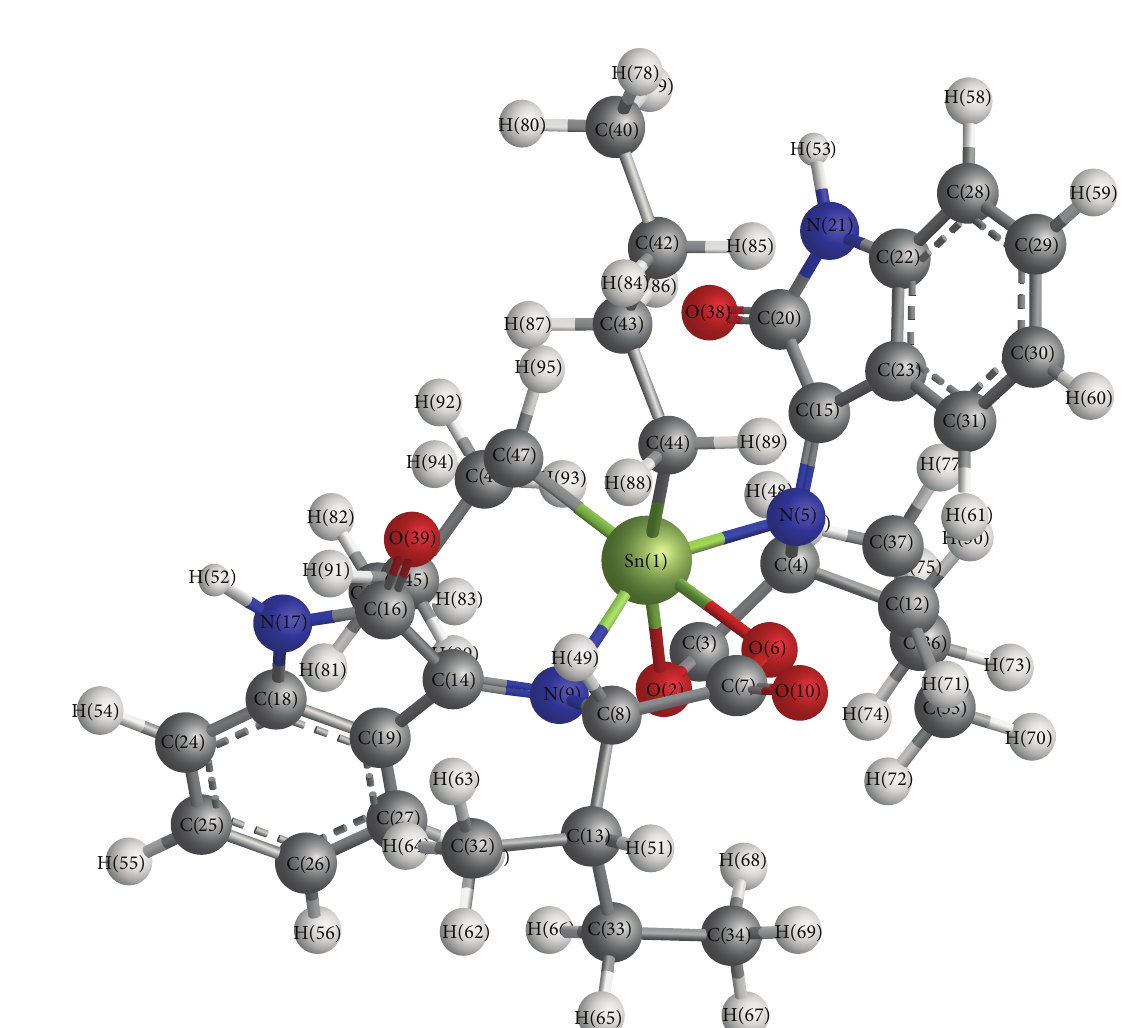
Figure 4: 3D molecular structure of Bu 2 Sn(L 2 ) 2